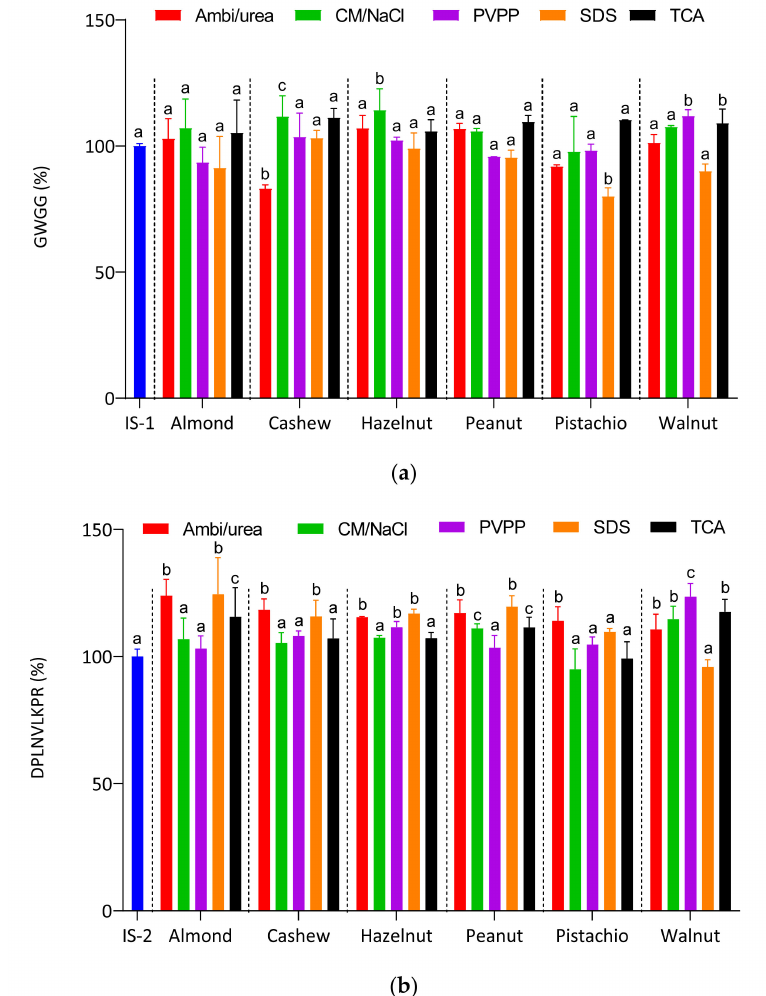
Figure 3. Recovery of the injected internal standards ( a ) GWGG and ( b ) DPLNV(d8)LKPR in the dif- ferent nut matrixes according to the extraction protocols: ammonium bicarbonate/urea (Ambi/urea), chloroform/methanol/sodium chloride (CM/NaCl), polyvinylpolypyrrolidone (PVPP), sodium dodecyl sulfate (SDS) and trichloroacetic acid (TCA). The results are expressed in percent internal standard detected ( n = 3). Comparisons were performed per family with internal standards IS1 and IS2 as reference, and different lowercase letters to the standards indicate significant differences at p = 0.05 (Tukey